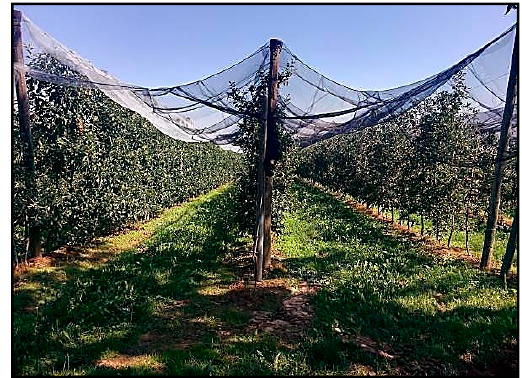
Figure 1. Tree spacing plantation layout of the apple orchard.